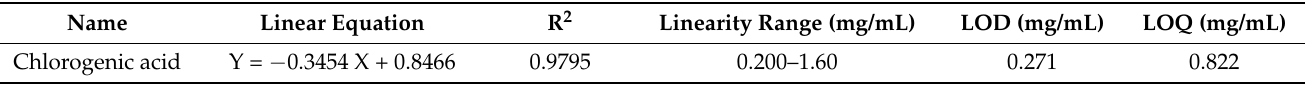
Table 3. Regression equation, correlation coefficient, and range of linear analysis for chlorogenic